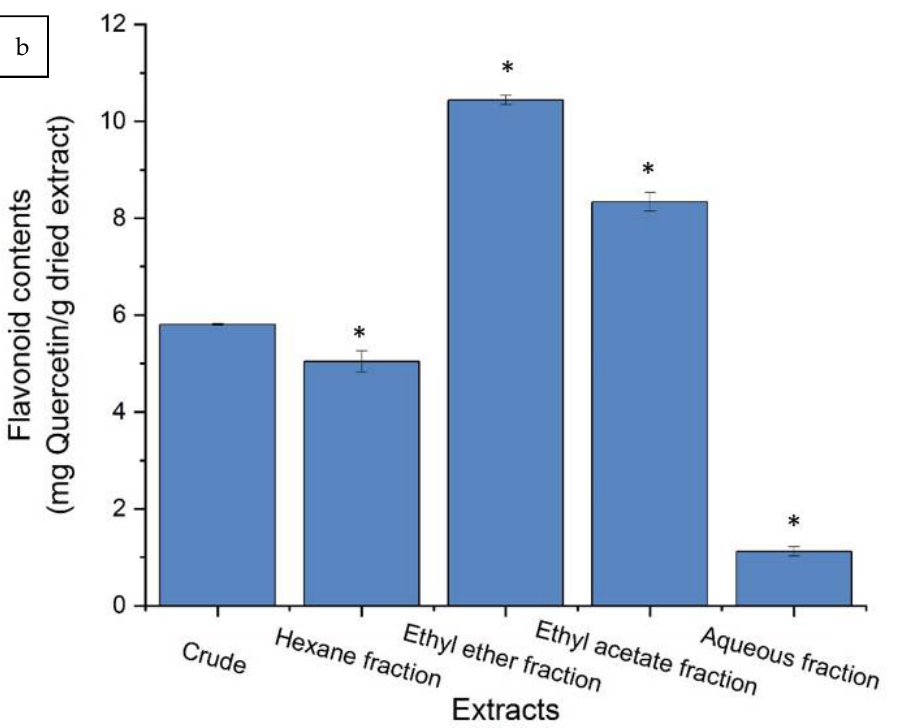
Figure 2. The total phenolic acids ( a ) and flavonoid contents ( b ) in crude and various solvent extracts of P. kadsura . Values are expressed as mean ± SD ( n = 3), * p < 0.05 for compared with crude group. Table 2. Antimicrobial activity of crude and various liquid-liquid extracts of P. kadsura .